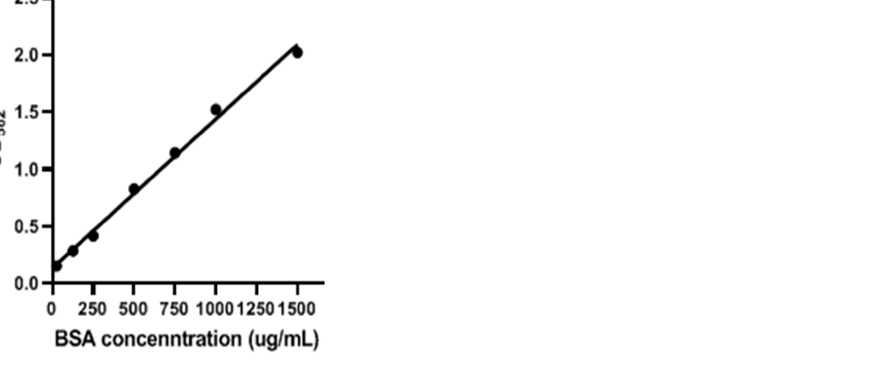
Figure 5. The standard curve for bovine serum albumin (BSA) based on the bicinchoninic acid (BCA) protein assay analysis.